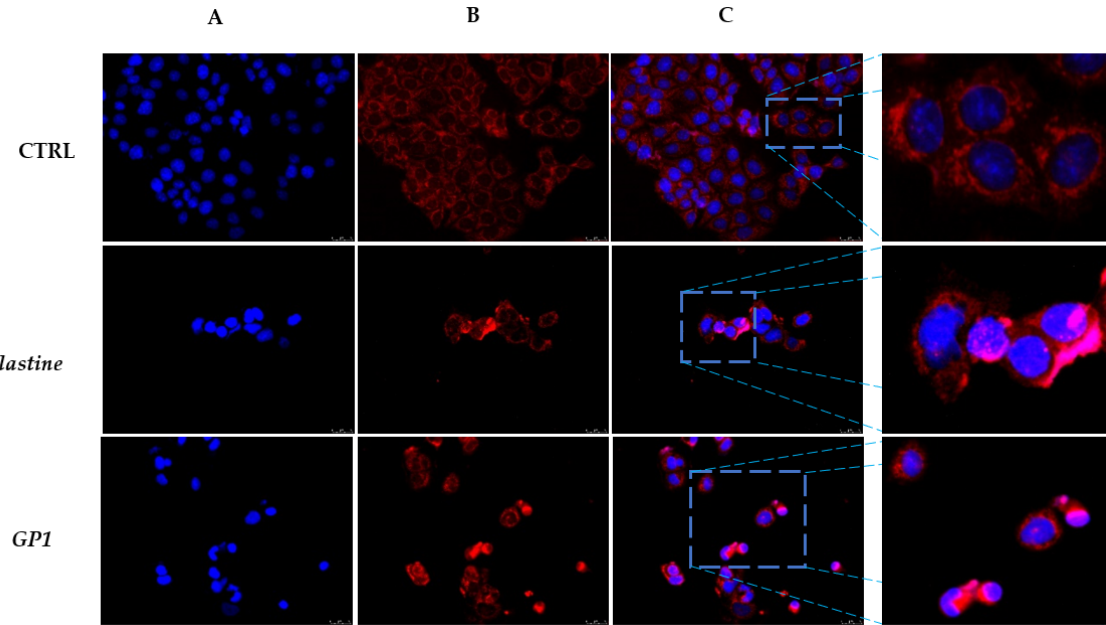
Figure 2. Immunofluorescence studies. MCF-7 cells were treated with compound 1 and vinblastine, used as a reference molecule, (IC 50 values) or with a vehicle (CTRL) for 24 h. After treatment, the cells were incubated with primary and secondary antibodies (see the Experimental section for more details) and then imaged under the inverted fluorescence microscope at 20 × magnification. CTRL cells (DMSO only) showed regular organization of the cytoskeleton (( B ), CTRL). MCF-7 cells treated with vinblastine and compound 1 exhibited irregular arrangement and organization, with tubulin filaments accumulated around cell nuclei (white arrows, ( B ), vinblastine and 1 ). ( A ) DAPI, excitation/emission wavelength 350 nm/460 nm; ( B ) tubulin (Alexa Fluor ® 568) excitation/emission wavelength 644 nm/665 nm; and ( C ) a merge. A zoom-in of the overlay channels is shown on the right. Images are representative of three independent experiments. Table 2. Energies of the complexes formed by tubulin and compounds 1 , 2 , and 3 , and protein residues interacting with the